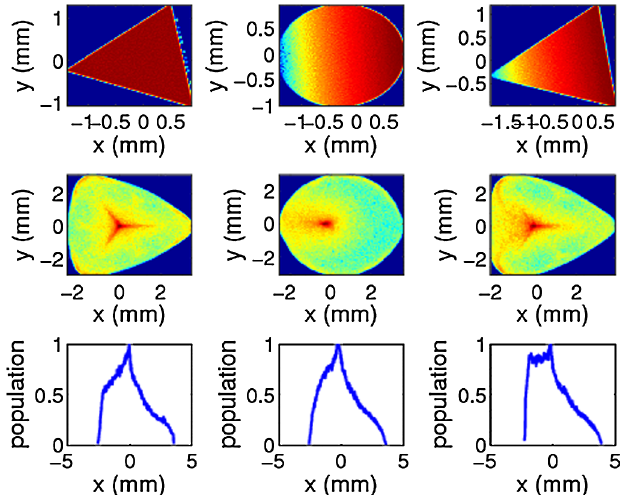
FIG. 13. Initial transverse densities on the photocathode sur- face (top row) and corresponding transverse densities (middle row) and horizontal profiles (bottom row) at z ¼ 2 : 79 m . The three columns, respectively, correspond to the case of a uniform- triangle distribution (left column), a circular distribution with a dipole moment (middle column), and a triangular-shaped distri- bution with a dipole moment (right column).